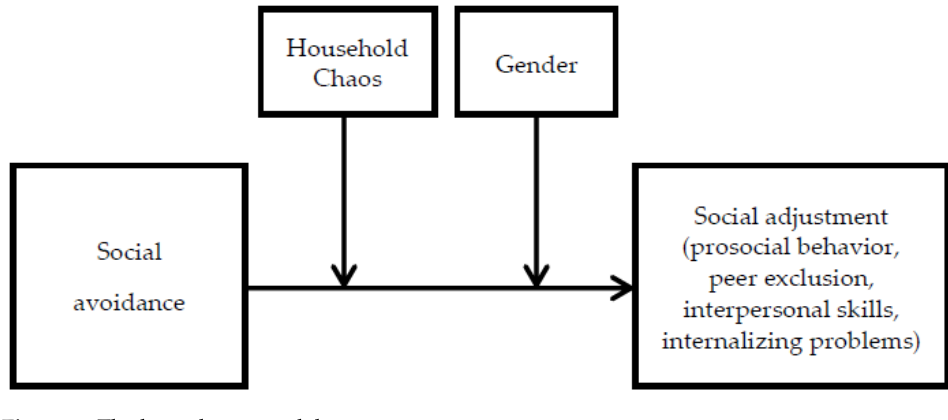
Figure 1. The hypotheses model.